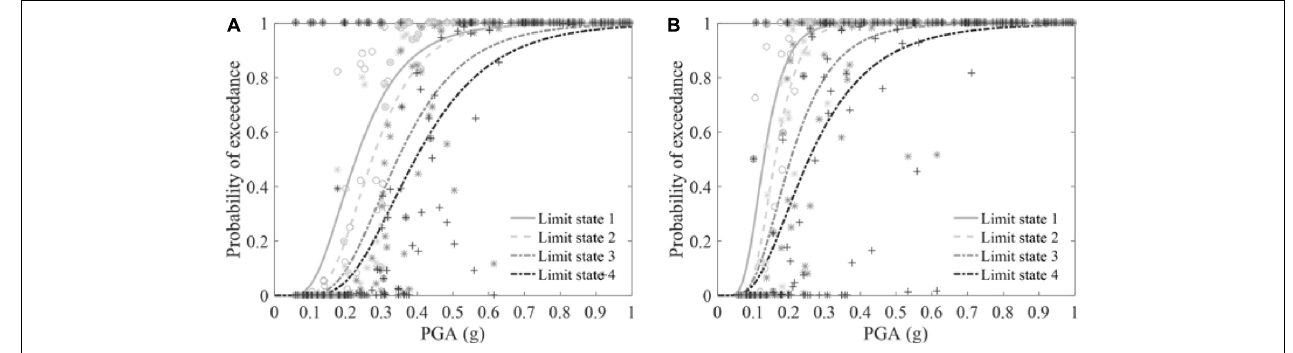
FIGURE 11 | Combined fragility curves for in-plane and out-of-plane associated with (A) one- and (B) two-story adobe